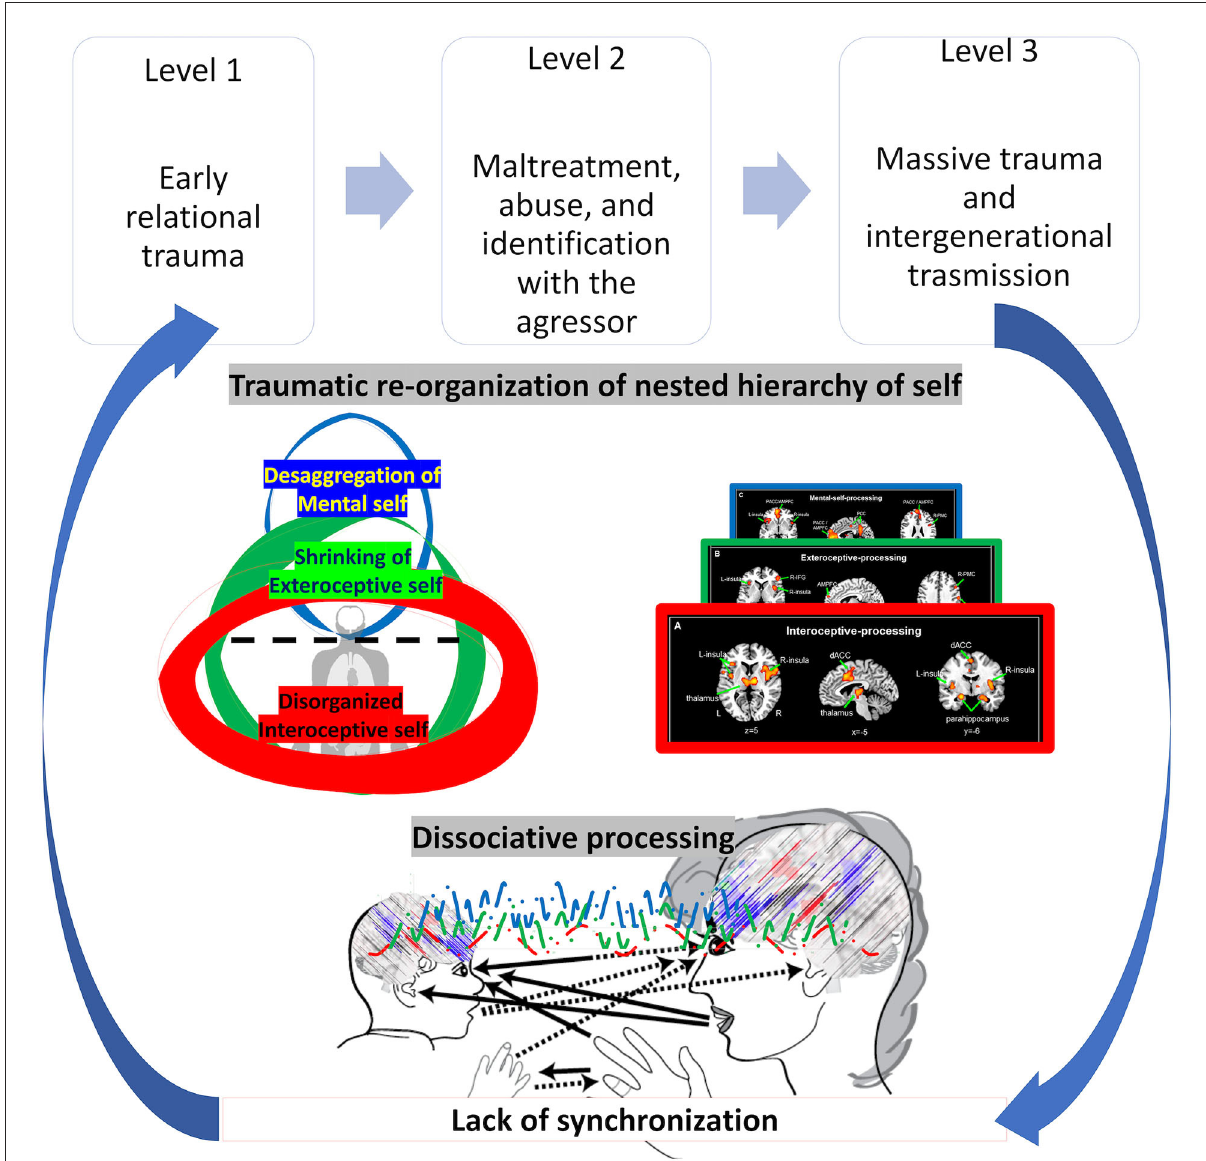
FIGURE10 Visual representation of the traumatic dynamic and topographical re-organization of nested hierarchy of